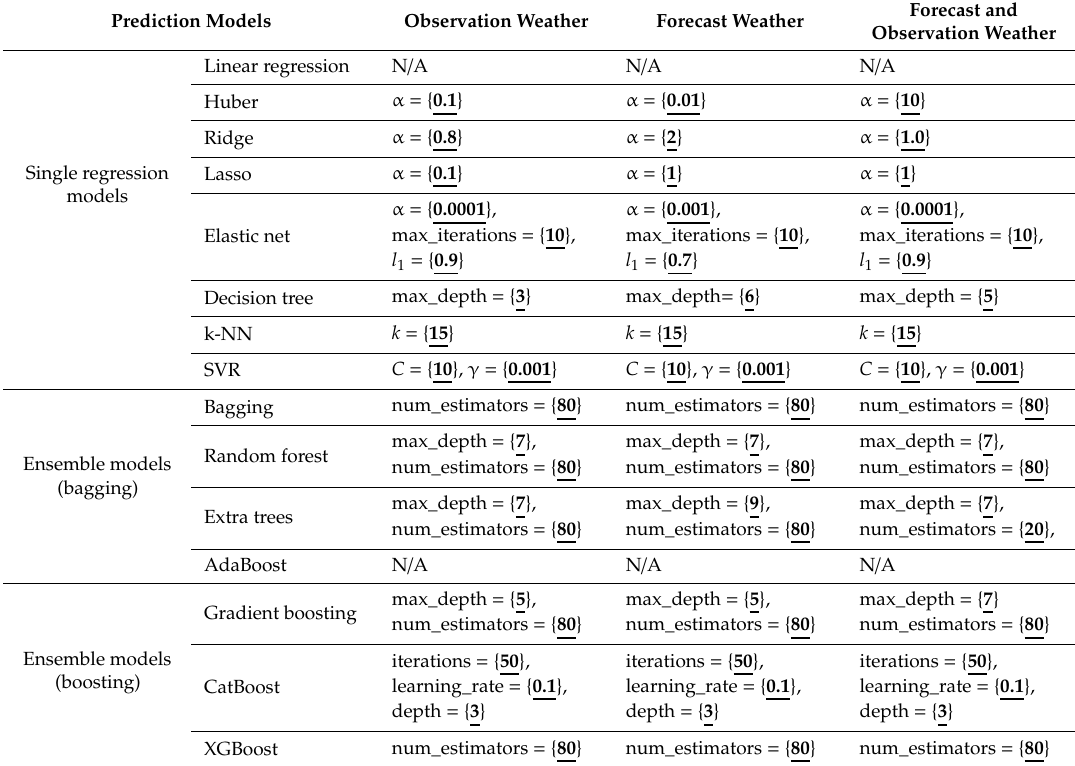
Table 4. Best values for the evaluated hyperparameter tuning from grid